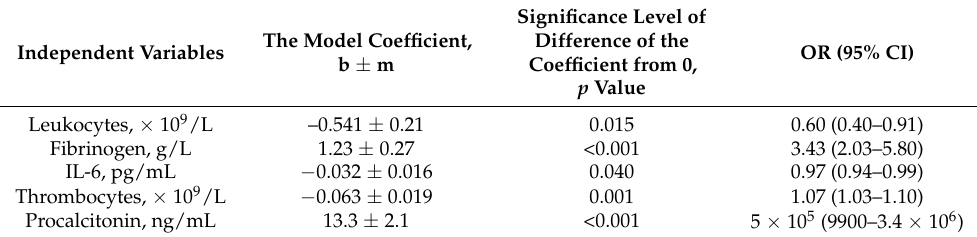
Table 6. Analysis of risk of death in a five-factor logistic regression model for the non-Delta group.